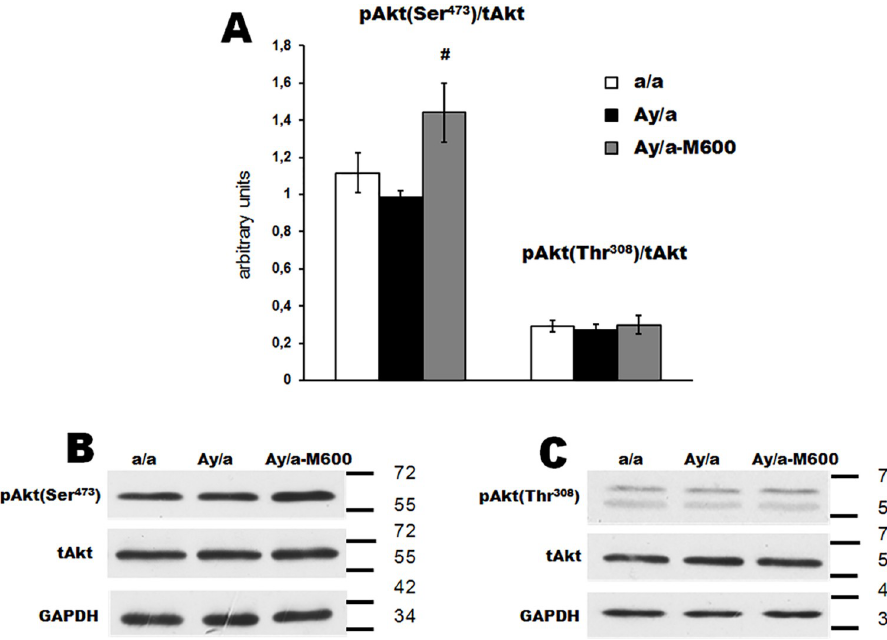
Fig 5. Phosphorylation of Akt-kinase in the hypothalamus of obese agouti-mice and the effect of metformin treatment. (A) The histograms for the ratio of the Ser 473 - and Thr 308 -phosphorylated and non-phosphorylated Akt- kinase. (B) and (C) The Western blotting for the Ser 473 - and Thr 308 -phosphorylated forms of Akt kinase, respectively. The data are presented as the M ± SEM . #—the difference between the Groups Ay/a and Ay/a-M600 is significant at the P < 0.05. In each group: n = 5.